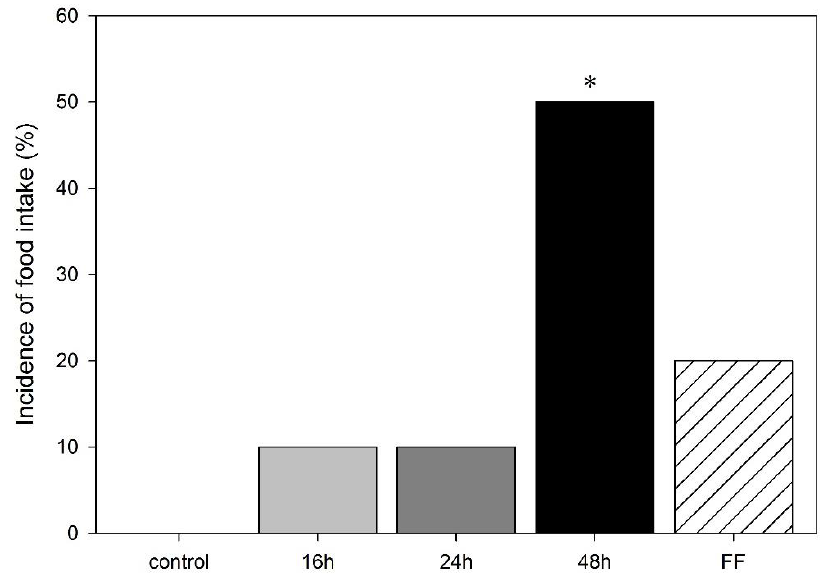
Figure 2. Percentage of rats feeding in the modified open field test in male and female rats following food deprivation (16 h, 24 h, 48 h), fixed-time feeding schedule (FF; 4 h for 4 days) or free feeding (control). Data is mean, * p < 0.05 vs. control.